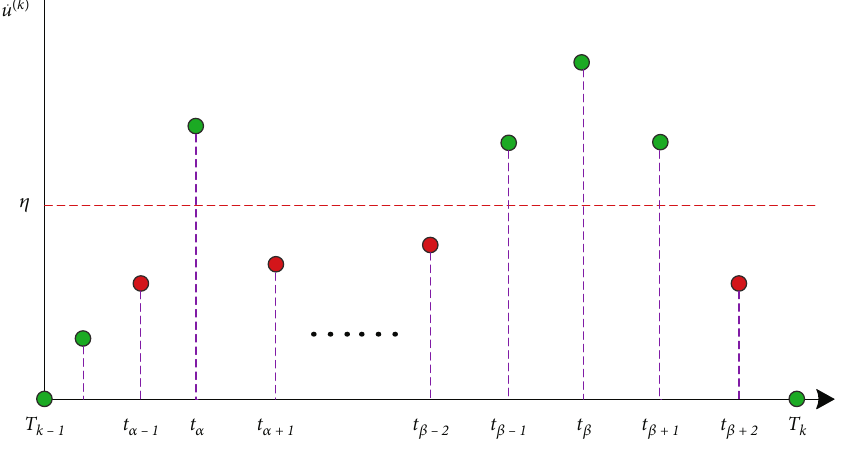
Figure 4: The derivative of control